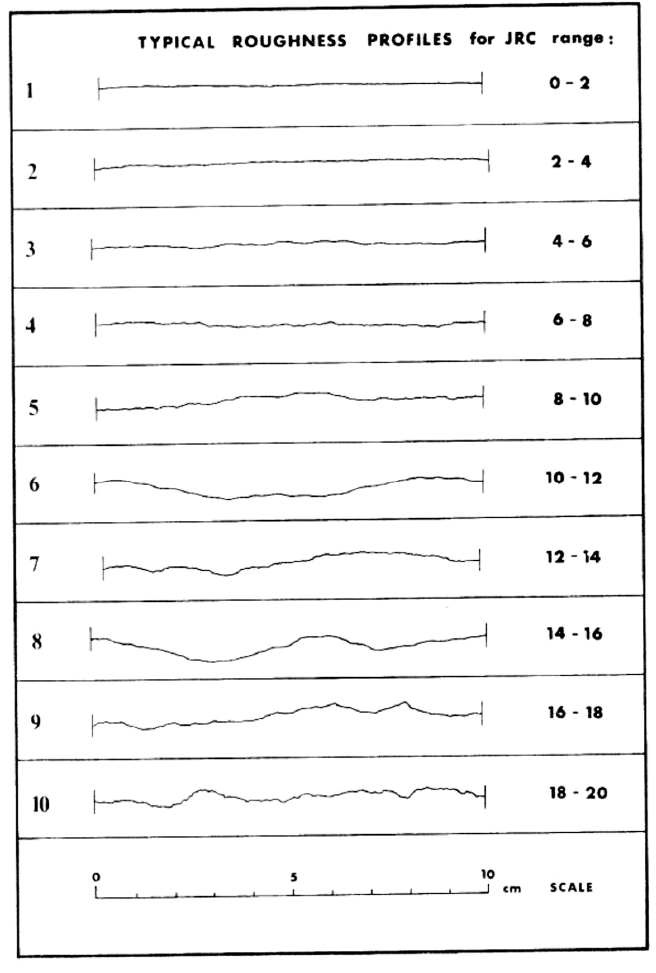
Figure A1. The ten standards profiles given by Barton and Choubey [4].